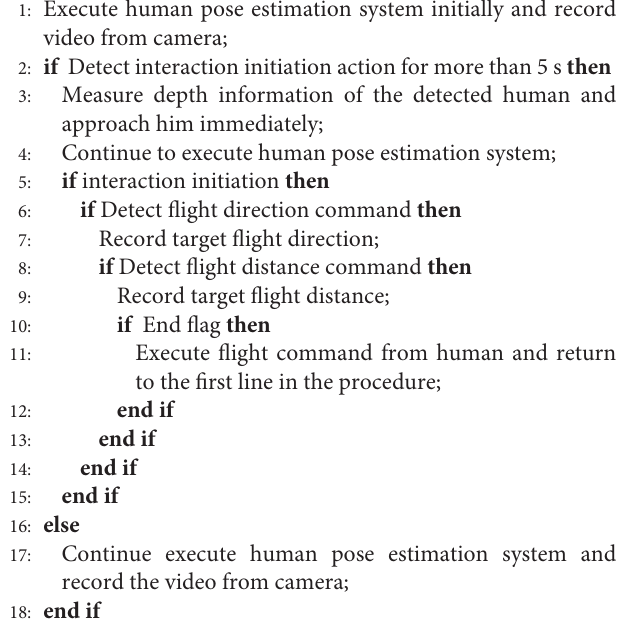
Algorithm 1: The Whole Interaction Procedure.